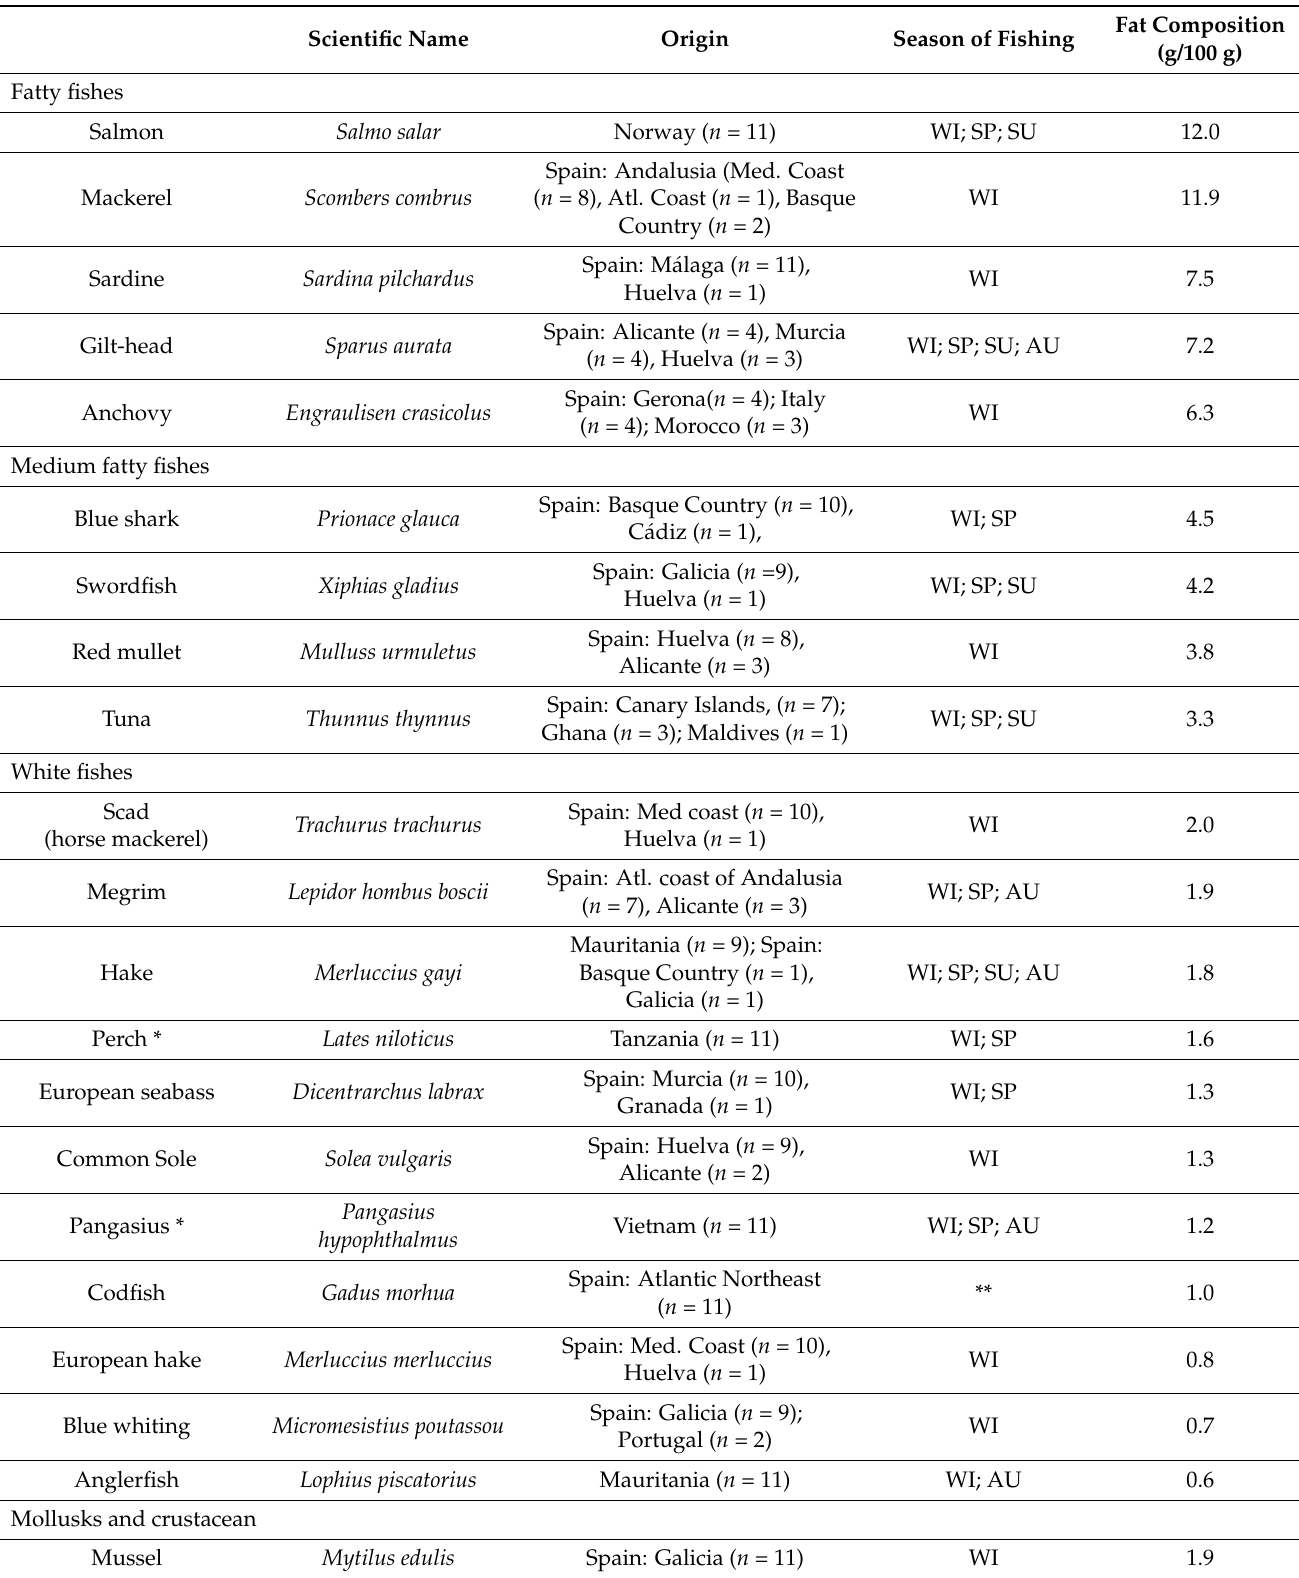
Table 1. Origin and fat composition of fatty, medium fatty, and white fresh fishes, mollusks and crustaceans usually consumed in